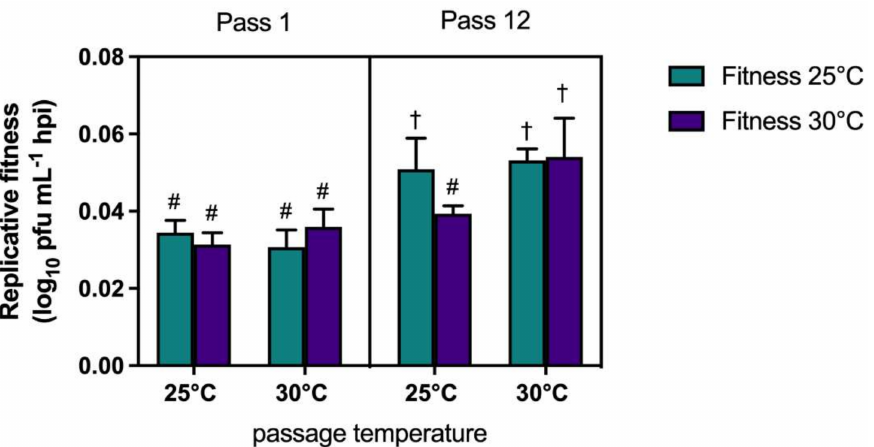
Figure 3. West Nile virus passage at increased temperatures facilitates temperature independent adaptation. Replicative fitness of WNV02 IC was assessed after 1 and 12 passages in Culex tarsalis (C × T) cells. Replicative fitness refers to the slope of the line of best fit determined via linear regression analysis of the log linear portion of individual growth curves. Data are shown as means of duplicate assays and lineages. Statistically different measures are indicated by unique characters ( p ≤ 0.05, three-way ANOVA w/multiple comparisons, Tukey’s post-test).